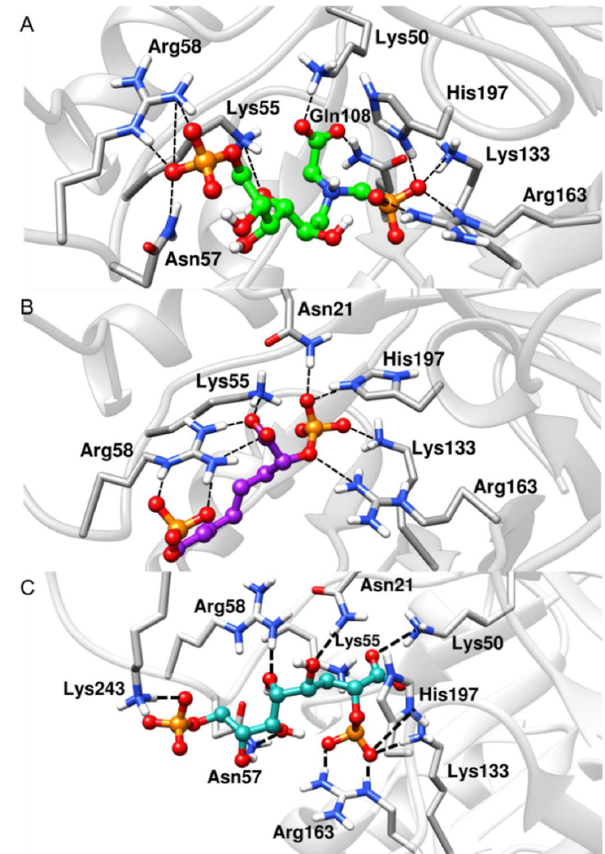
Figure 5. Representative structures along the MD simulations. ( A ) BPH1-KDO8P synthase, ( B ) BPH2-KDO8P synthase, and ( C ) BPH3-KDO8P synthase complexes. We can see important interactions of phosphate groups of the inhibitors with positively charged groups of KDO8P synthase.